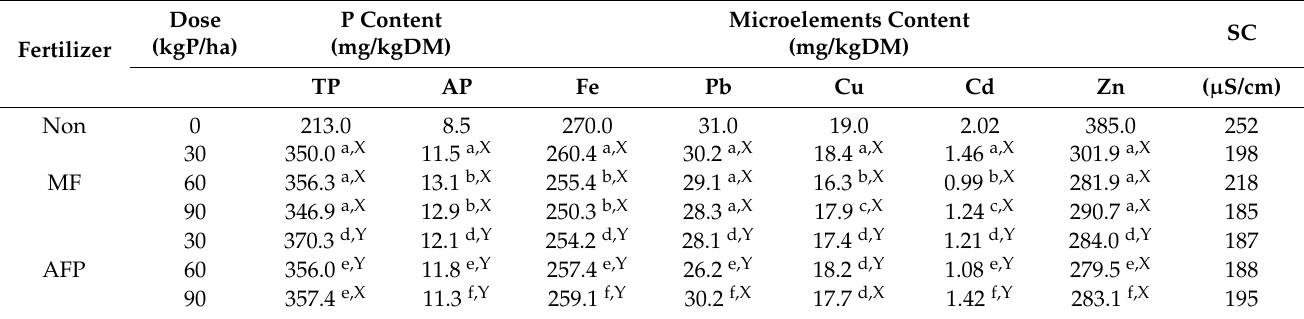
Table 4. Soil chemical composition as a function of fertilizer type and